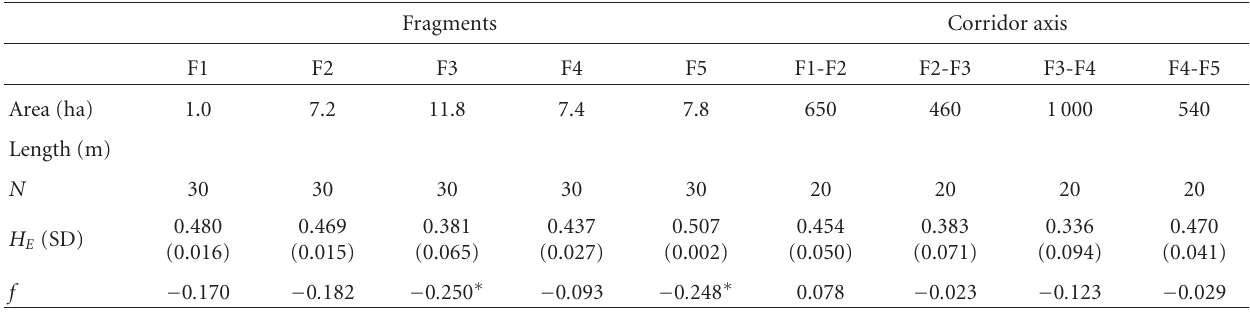
Table 1: Fragments and corridors code sampled in this study.